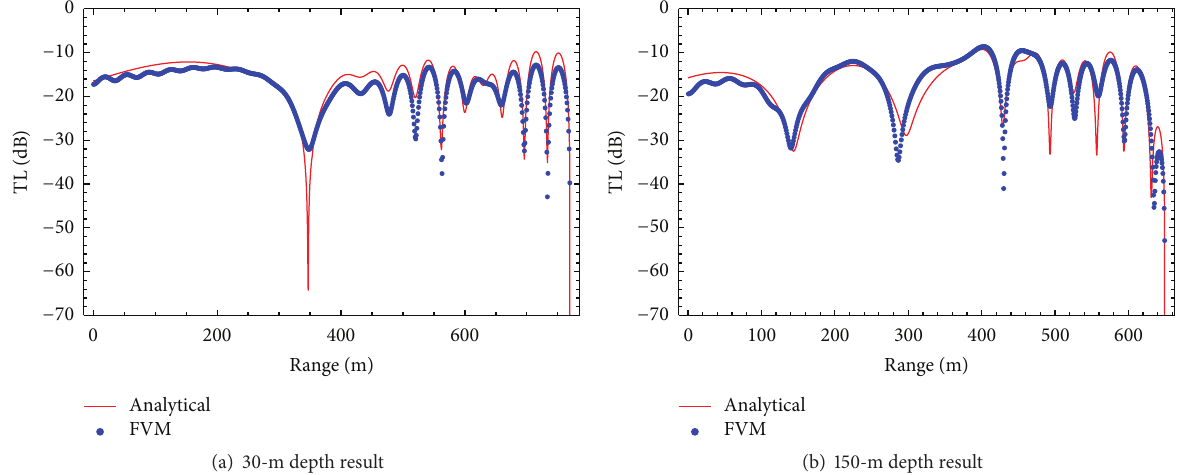
Figure 6: Comparisons of the Fourier transform of the FVM simulation and the analytical solution to the pressure-release bottom problem: (a) TL result at depth of 30 m; (b) TL result at depth of 150 m.